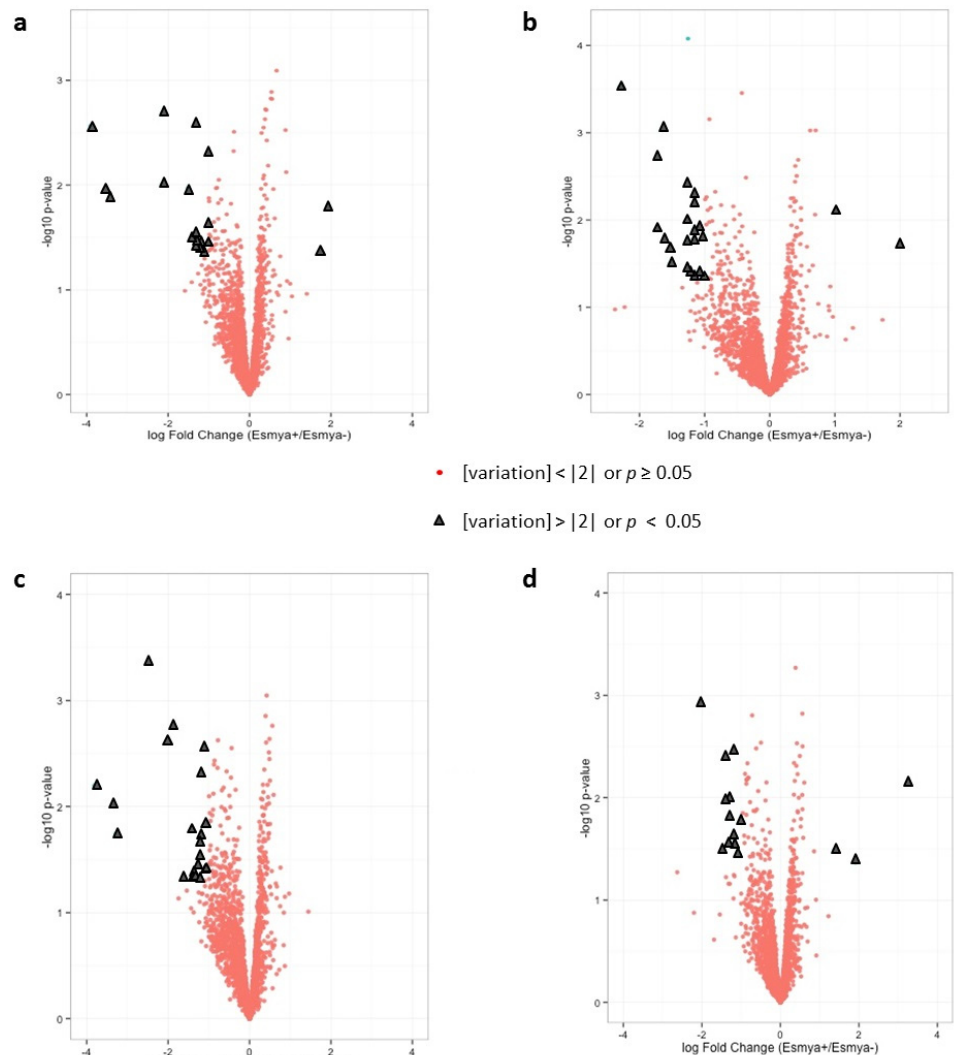
Figure 2. Volcano plot. Abscissa is the logarithmic value of the level of variation (log-ratio) and ordinate is the negative logarithm of the statistical value ( − log ( p )) of fluorescence intensities of the hybridized probes. The cut-off of p < 0.05 ( − log p > 1.3) and fold change (FC) > |2| identified two up-regulated and 17 down-regulated miRNA in UPA group versus proliferative phase group in superficial layer ( a ); two up-regulated and 17 down-regulated miRNA in UPA group versus secretory phase group in superficial layer ( b ); 21 down-regulated miRNA in UPA group versus proliferative phase group in basal layer ( c ); and three up-regulated and 12 down-regulated miRNA in UPA group versus secretory phase group in basal layer ( d ).